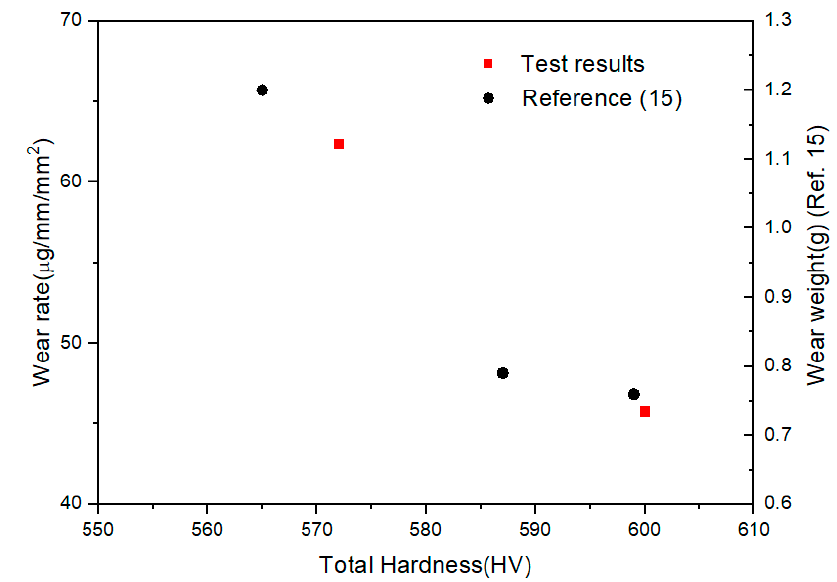
Figure 19. Relationship between total hardness and wear.